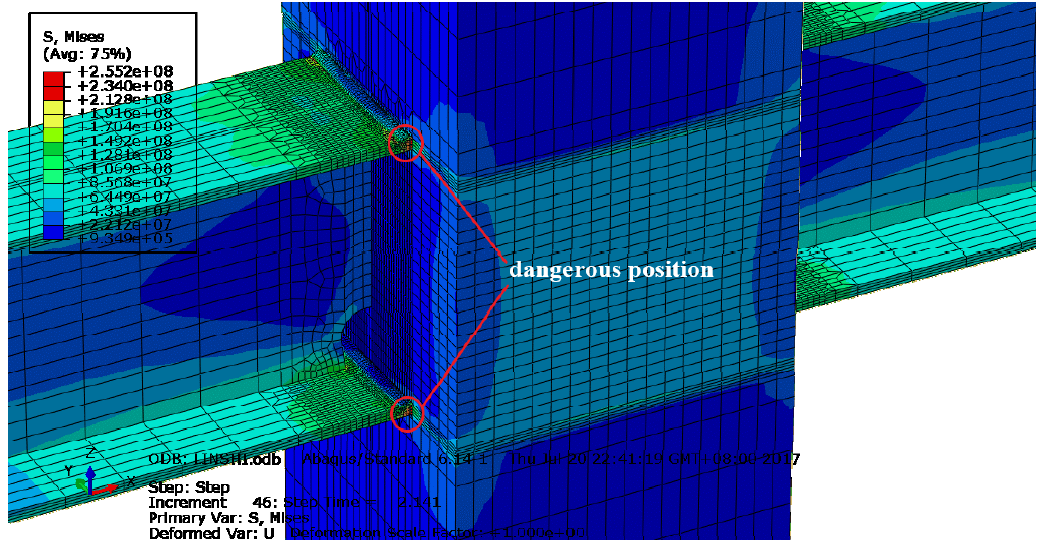
Figure 6. von Mises stress distribution nephogram.